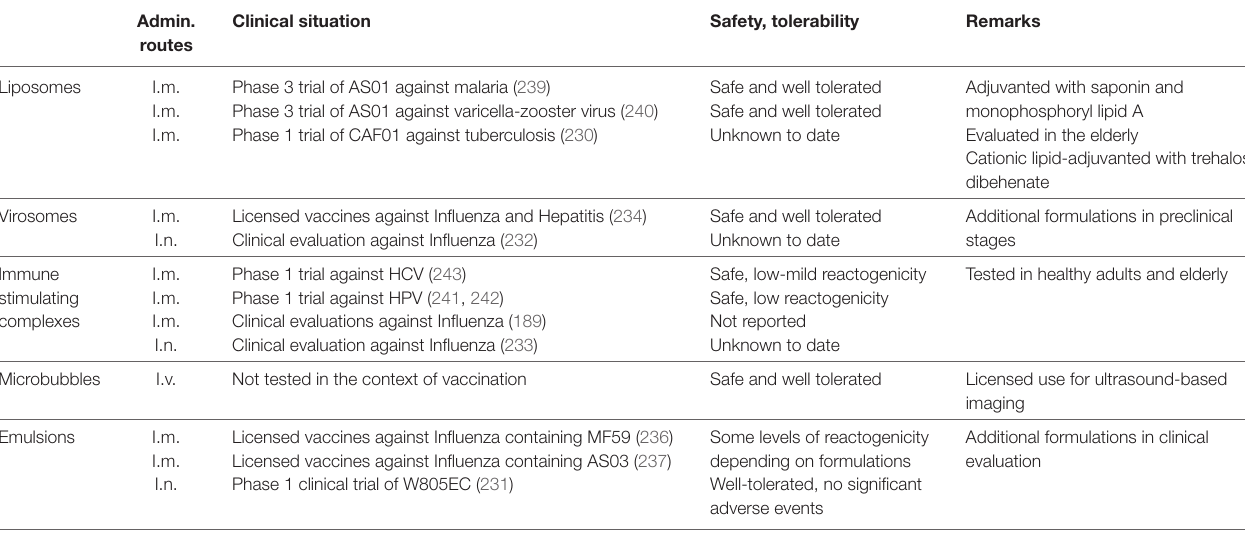
TABLe 2 | Examples of licensed and in development lipid-based vaccines for human use. Admin.